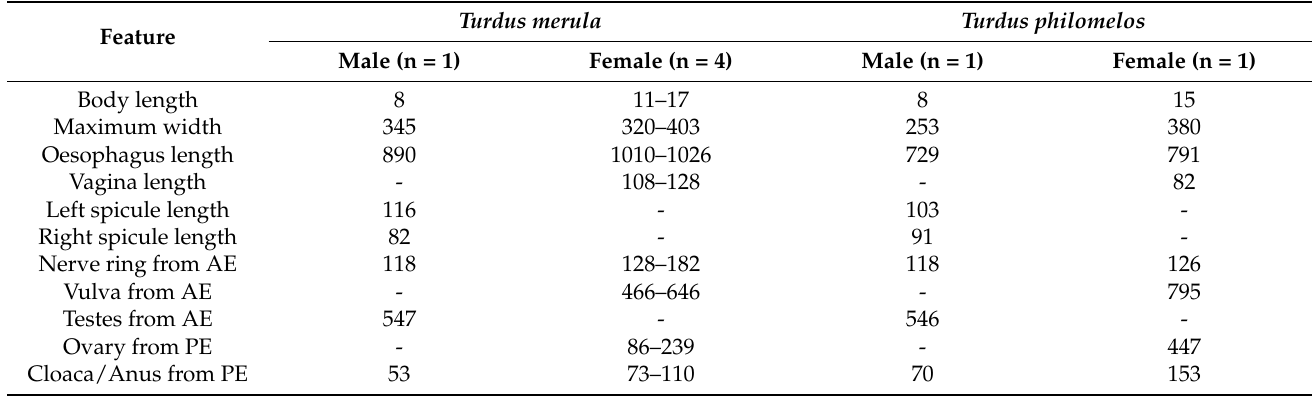
Table 4. Measurements of adult Splendidofilaria mavis from the Eurasian blackbird ( Turdus merula ) and the Song thrush ( Turdus philomelos ) that were examined in this study. All measurements are given in micrometres, except for body length, which is given in